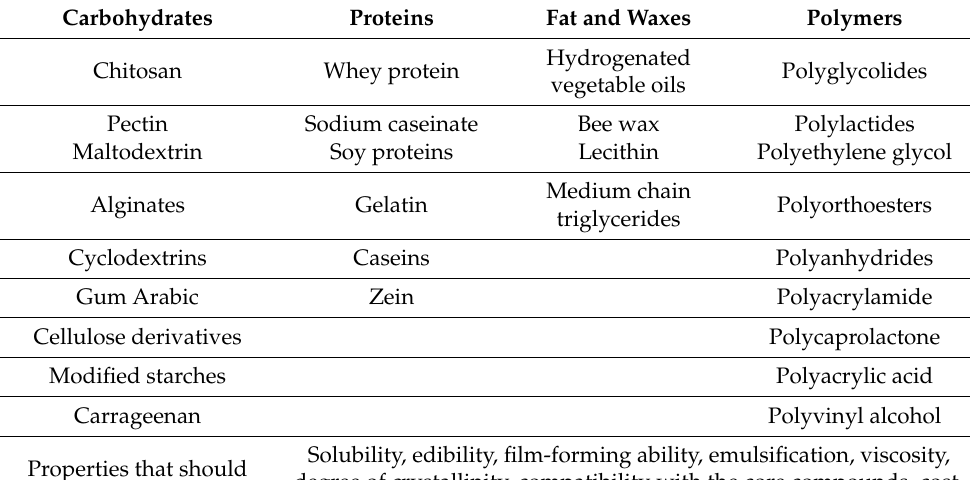
Table 2. Commonly used wall materials for encapsulation of food components and representative characteristics to bear in